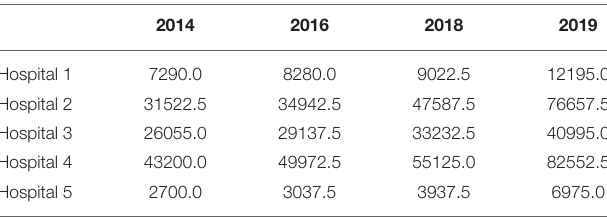
TABLE 6 | Total annual utilisation of insulin glargine (DDDs) among 5 Government hospitals in